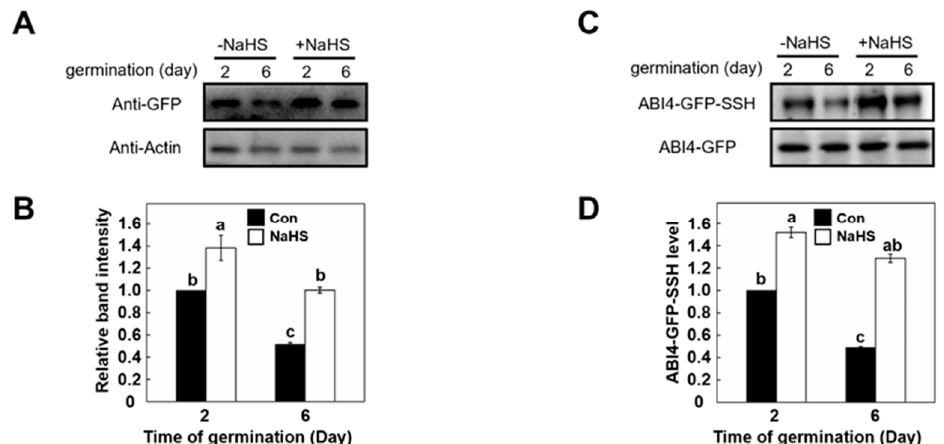
Figure 3. The stability and persulfidation level of ABI4 during germination and post-germination growth. ( A ) NaHS affects the ABI4 protein level In vivo. 35S:ABI4-GFP transgenic seedlings grown on 1 / 2 MS medium with or without NaHS (0.1 mM) were harvested at the indicated times. Total proteins were extracted and then checked by immunoblot analysis. ABI4 proteins were detected using an anti-GFP antibody. Relative amounts of proteins were determined by densitometry normalized to actin. ( B ) Quantification of the relative band intensity shown in ( A ). ( C ) Effect of the NaHS on the persulfidation of ABI4 In vivo. Sample treatments were as described for ( A ). Total proteins were extracted and then subjected to the biotin-switch assay to analyze persulfidation levels (ABI4-GFP-SSH). Persulfidated ABI4-GFP protein was detected with anti-GFP antibody after tag-switch labeling and streptavidin purification. The bottom panels show the total ABI4-GFP used for the tag-switch assay as a loading control. ( D ) Quantification of the ABI4-GFP-SSH level is shown in ( C ). For ( B , D ), the bars indicate the relative abundance of the corresponding protein ( B ) or persulfidated protein ( D ) compared with that of the control un-treated sample (set to 1.0). Signals from two independent experiments were quantified. Different letters indicate significant differences at p < 0.05 according to one-way ANOVA (post-hoc Tukey’s HSD test).